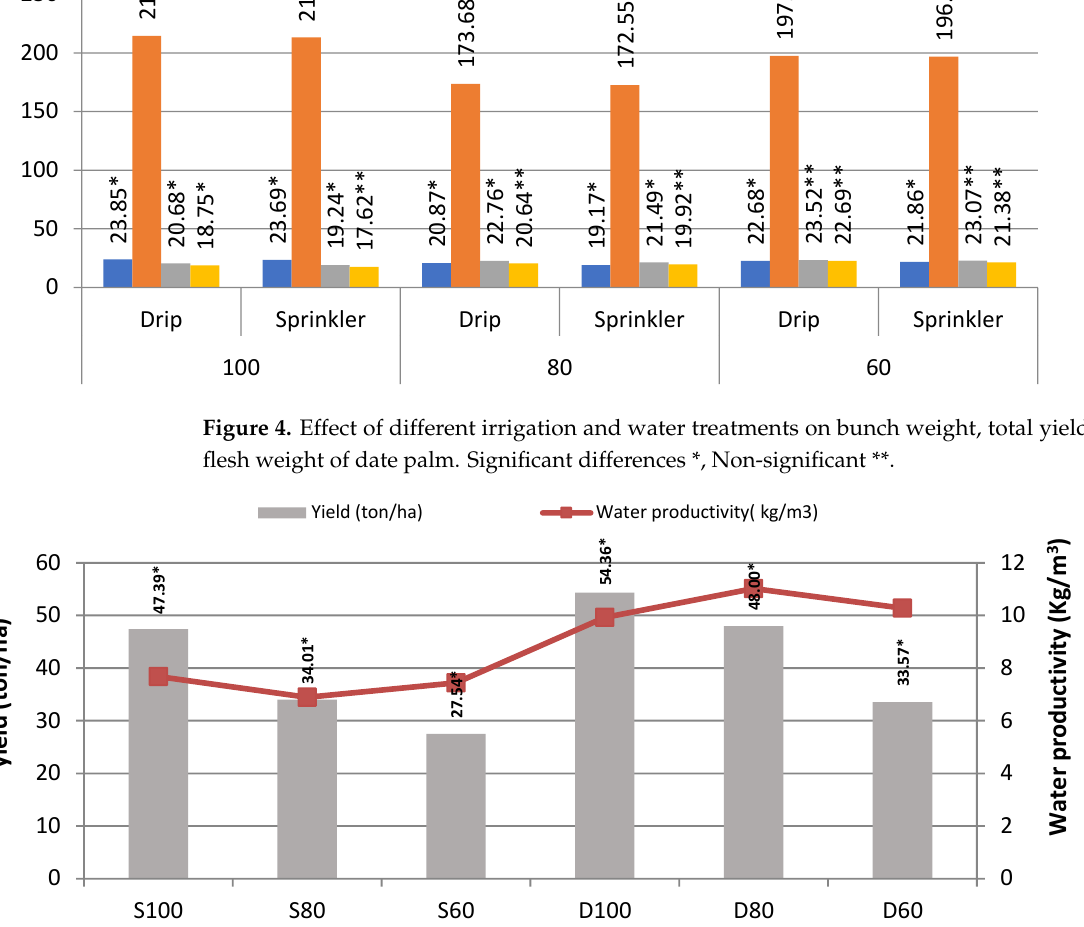
Figure 5. Yield and water productivity under different irrigation systems with different regimes. Significant differences *, Non-significant **, (ha): Hectare, WP: Water productivity, M 3 : Quebec meter.